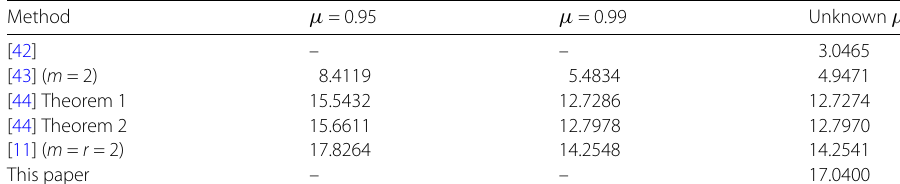
Table 9 Maximum allowable bounds of h M for different values of μ in Example 4.3